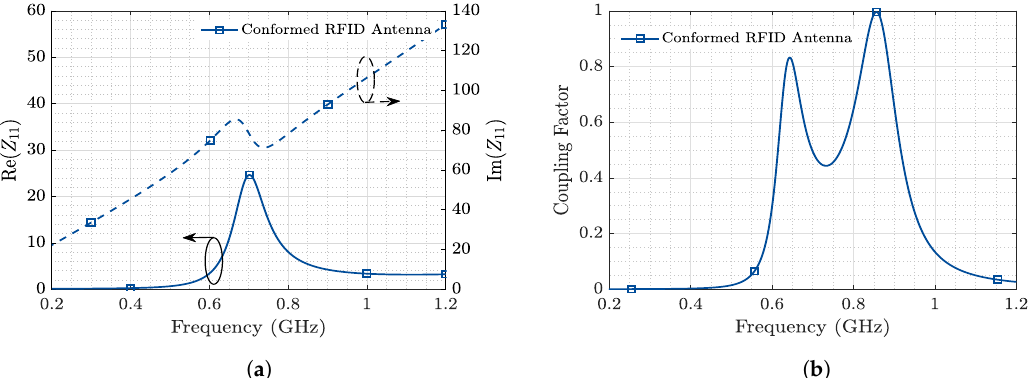
Figure 3. Antenna parameters: ( a ) Input impedance. Re( Z 11 ) left vertical axis and Im( Z 11 ) right vertical axis and ( b ) impedance coupling factor.